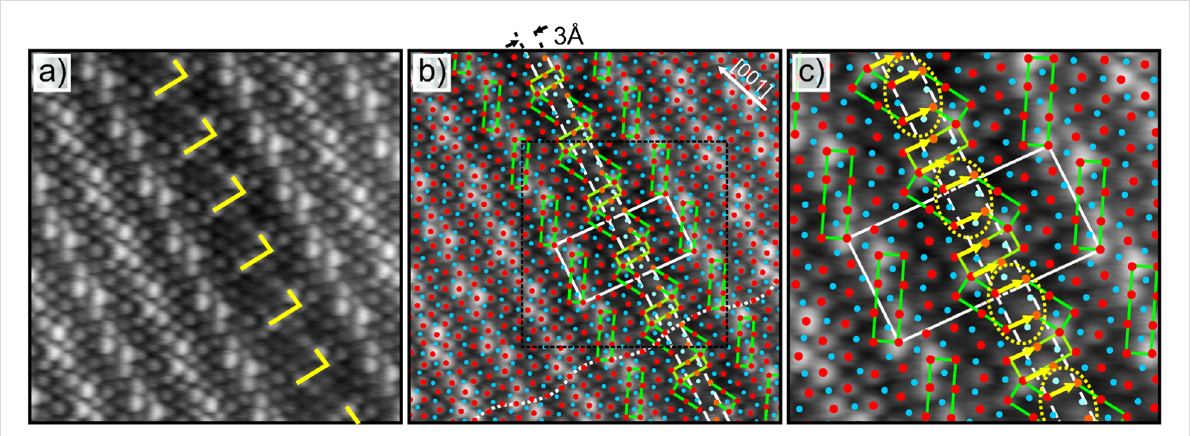
Figure 10: Atomic resolution NC-AFM image of a straight antiphase domain boundary (type I) in the aluminum oxide on NiAl(110). The scan area is 6.4 nm × 6.4 nm in (a) and (b). b) An adjusted model [47] has been superimposed. The unit cell is extended by 3 Å along the long edge of the unit cell. Inserted sites are given in lighter colors. Dashed lines indicate the extension. The dotted line highlights wave-like oxygen rows along the unit cell. c) shows an enlarged section of the image for better visibility (3.5 nm × 3.5 nm). Yellow arrows denote the direction and length (3 Å) of the Burgers vector. Yellow loops indicate spacious arrangements of oxygen sites that are different from all domain sites. Δ f = − 2.75 Hz, A osc = 3.8 Å, U bias = − 220